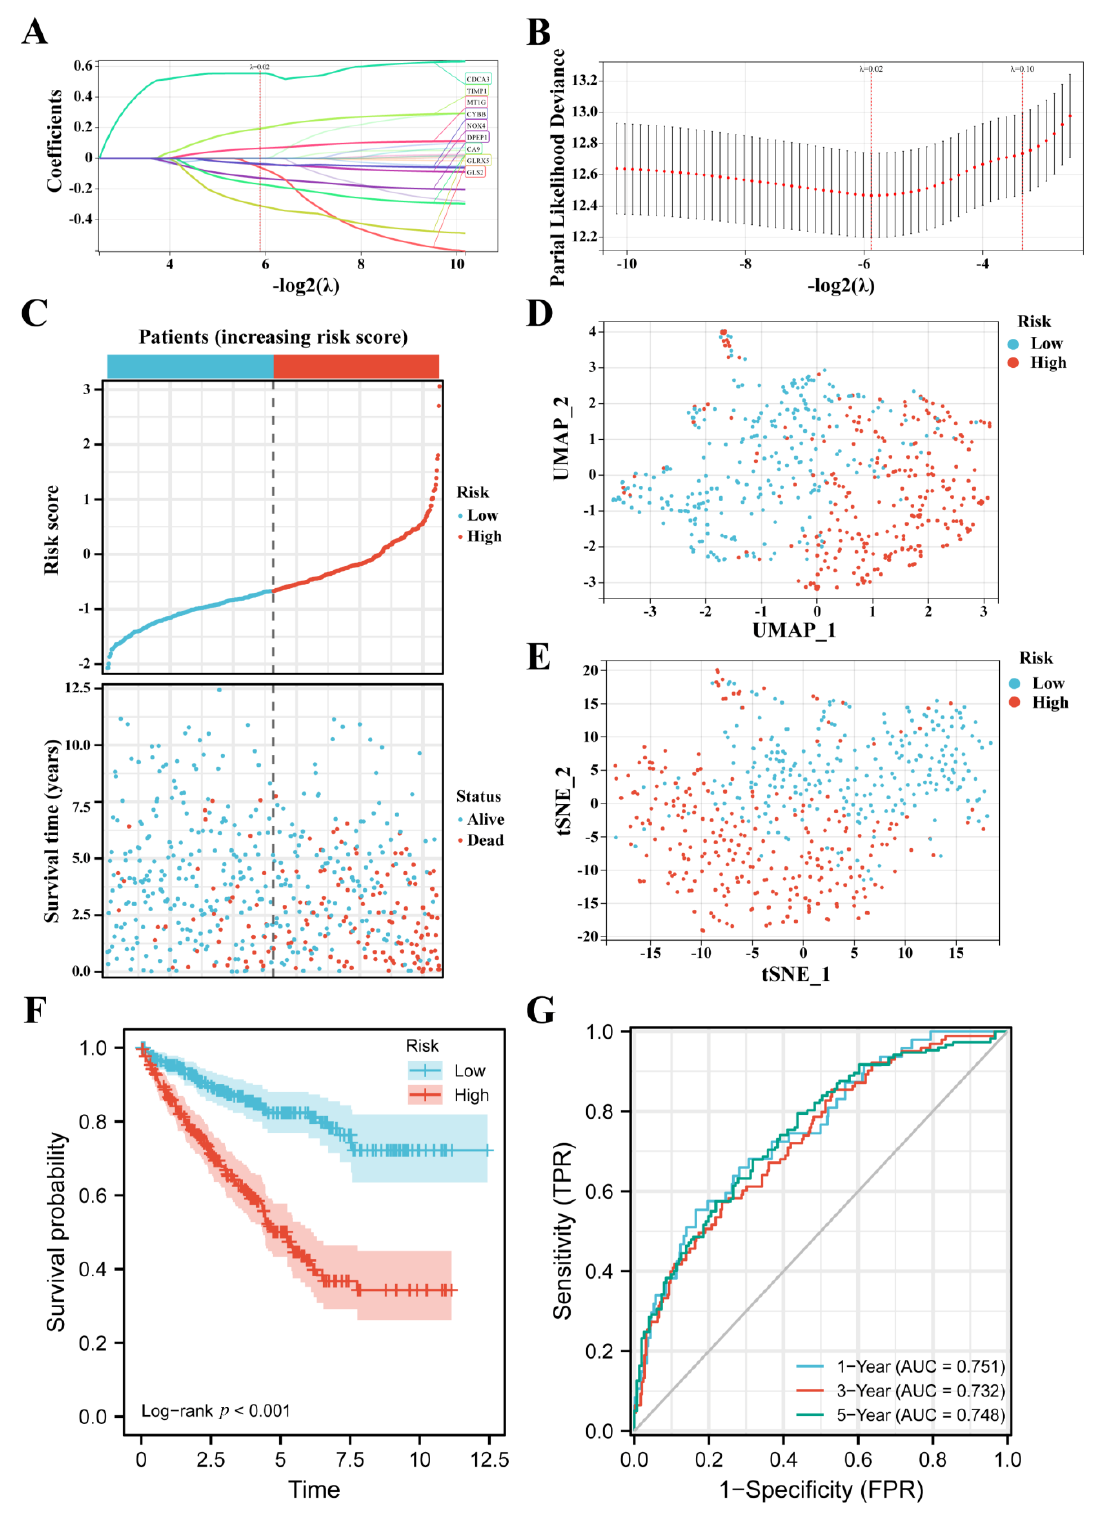
Figure 3. Construction of the FPM in TCGA. ( A , B ) LASSO Cox regression analyzed FPDEGs. ( C ) Distributions and media value of ccRCC patients with increasing risk score and distribution of ccRCC patients with corresponding survival status. ( D ) UMAP plot of the ccRCC patients showing the distribution in two risk groups. ( E ) t — SNE plot of the ccRCC patients showing the distribution in two risk groups. ( F ) K – M curves of patients in two risk groups. ( G ) AUC of the time-dependent ROC curves showing the prognostic value of the risk score.